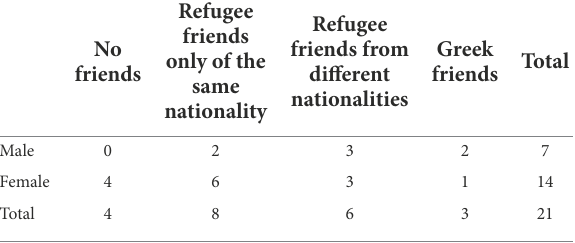
TABLE 2 Refugee children’s friendships and duration of stay in Greece.